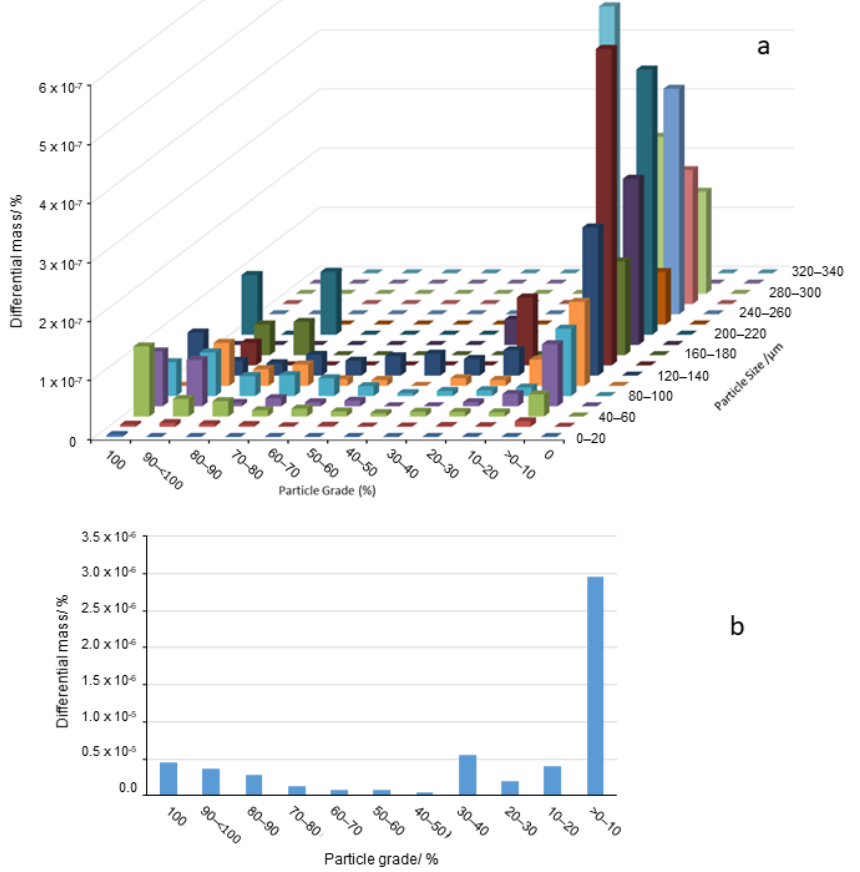
Figure 11. Distribution of monazite in the concentrated materials: ( a ) according to particle size and cassiterite grade classes; ( b ) according to the grade. The zero grade particles are not shown.